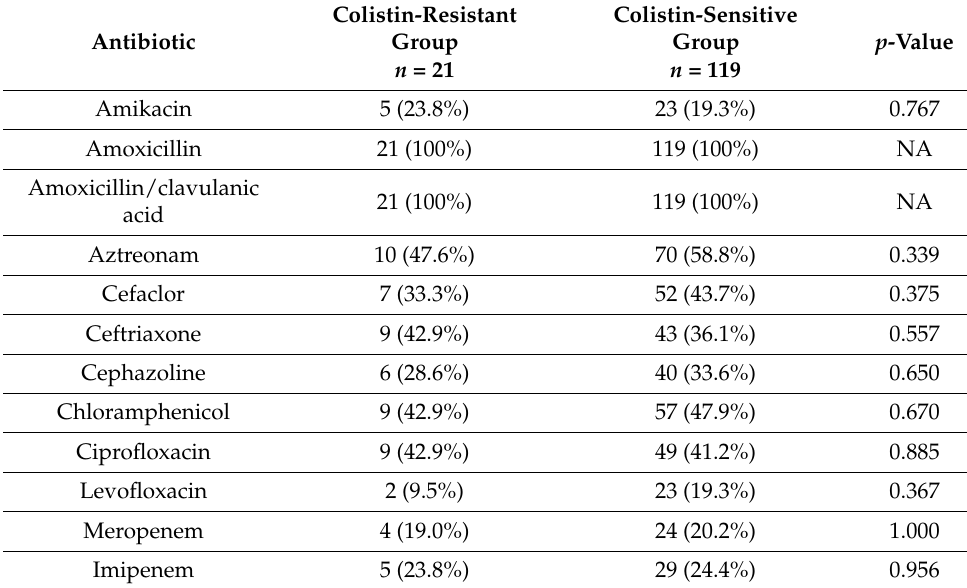
Table 3. Co-resistance profile and resistance-associated genes for E. coli